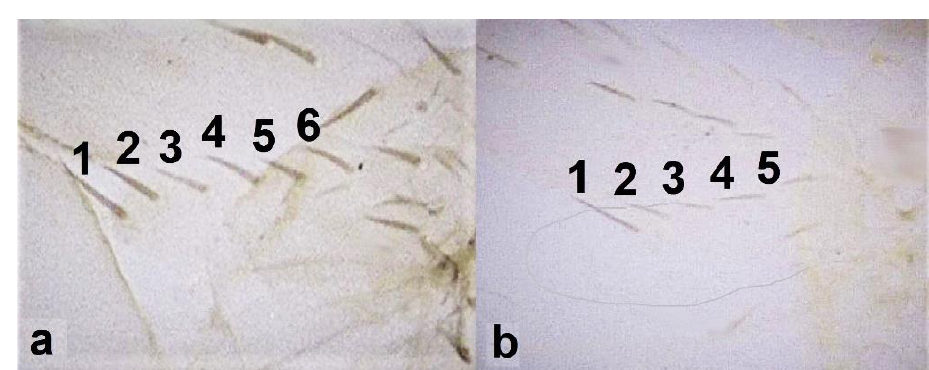
33 Fore wing clavus with five marginal setae (Figure 32a); second vein of fore wing with 8–10 setae .................................................................................. Tenothrips discolor (Karny) Fore wing clavus with six marginal setae (Figure 32b); second vein of fore wing with 11 or more setae ................................................................................................................. 34